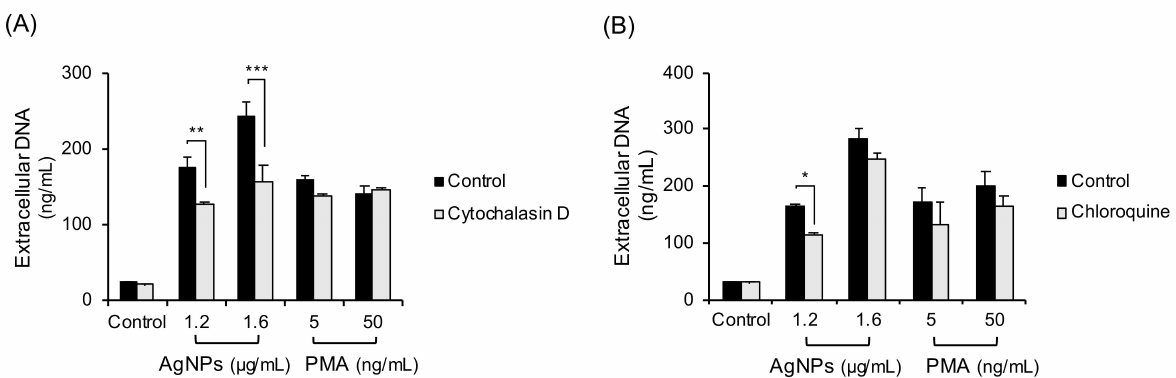
Figure 4. Inhibition experiments with non-thiol antioxidants in 5 nm AgNP-treated neutrophils. Human neutrophils were pretreated with non-thiol antioxidants: ( A ) trolox (100 µ M, 1 h) or ( B ) L-ascorbic acid (20 µ M, 1 h) and treated with AgNPs or PMA for 4 h. Extracellular DNA were measured using a fluorescence plate reader. Two-way ANOVA was used to determine the significance (* p < 0.05, ** p < 0.01, *** p < 0.001). All experiments were performed in duplicate and repeated three times with different volunteers.